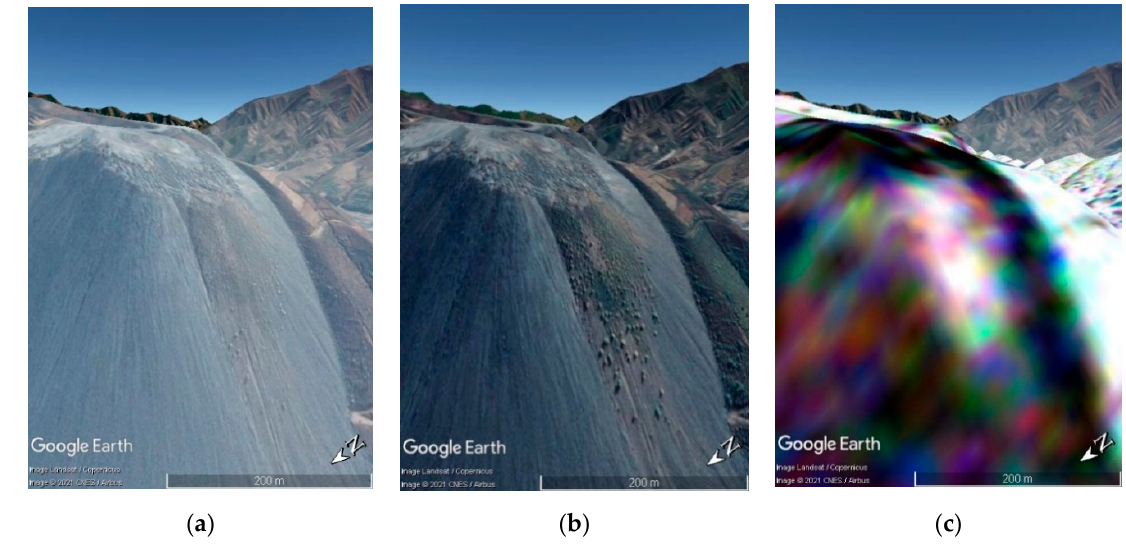
Figure 17. West Dumping Site 4 (WD4). ( a , b ) are Google Earth images taken on 7 October 2015 and 26 September 2019, respectively. ( c ) is the RGB composite of the annually averaged NDAI map (R: 2019, G: 2018, and B: 2017).